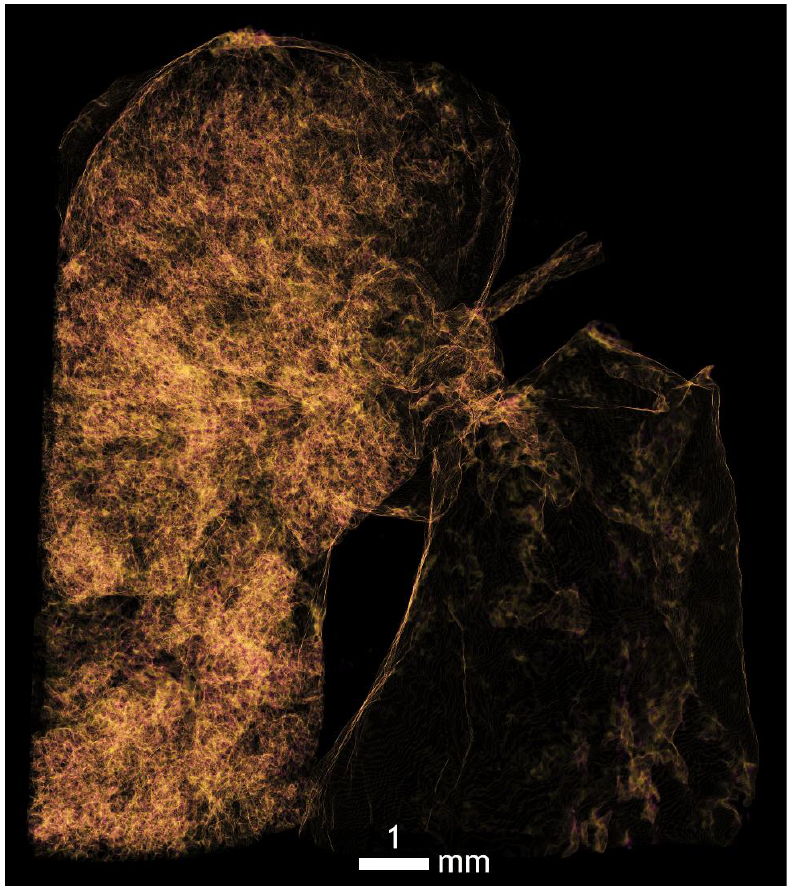
Figure A9. Ideal right lung position for imaging of bronchial branching down to alveolar levels using Omnipaque contrast. The right lung is rotated in a different position and it is possible that post-mortem it collapsed, mechanically vented, or was fixed in the fluid.